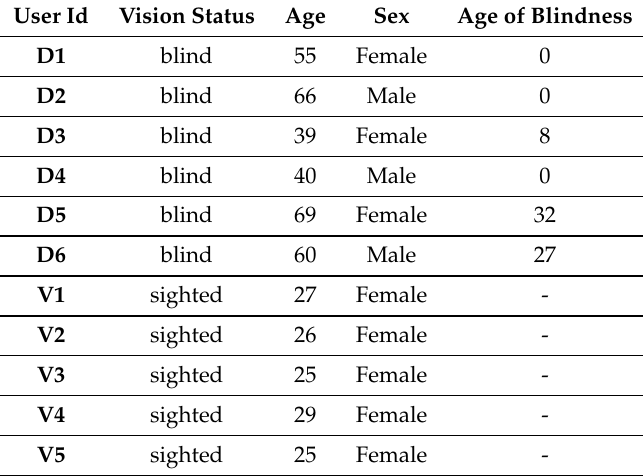
Figure 8. Comparing web page structures depending on associated amplitude values. Table 3. Characteristics of the blind and sighted population.